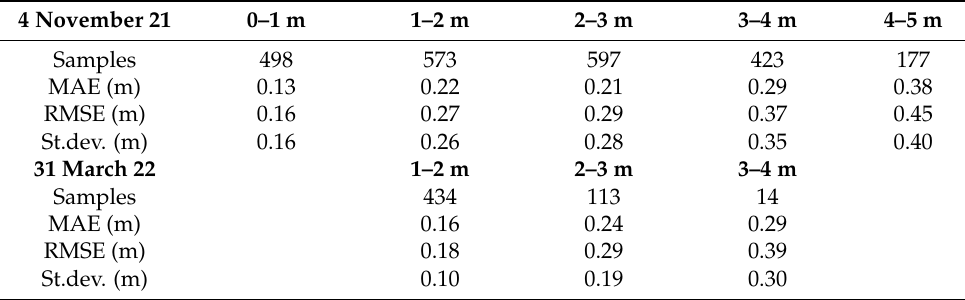
Figure 3. ( A ) Bathymetry inversion output for the November-2021 dataset. Black polygons indicate erroneous results due to the presence of seagrass patches; ( B ) Linear regression between modelled and measured depth for the November-2021 datasets; ( C ) Bathymetry inversion output for the March-2022 dataset; ( D ) Linear regression between modelled and measured depth for the March-2022 datasets. The red line in the regression plots indicates the linear trend of the correlation. Table 1. Descriptive statistics of bathymetry residuals per depth